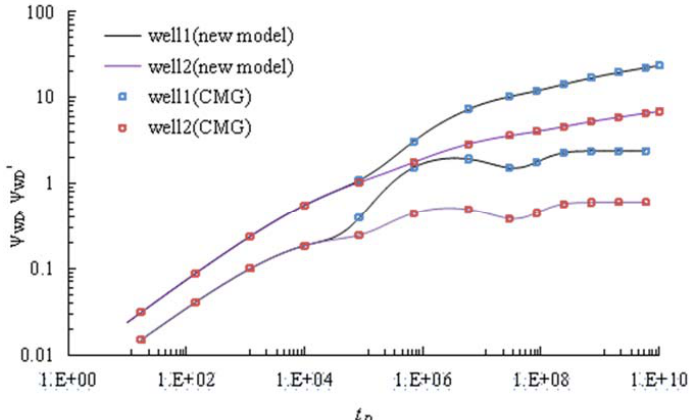
Figure 6. Comparison of our results of model with that of CMG simulator.